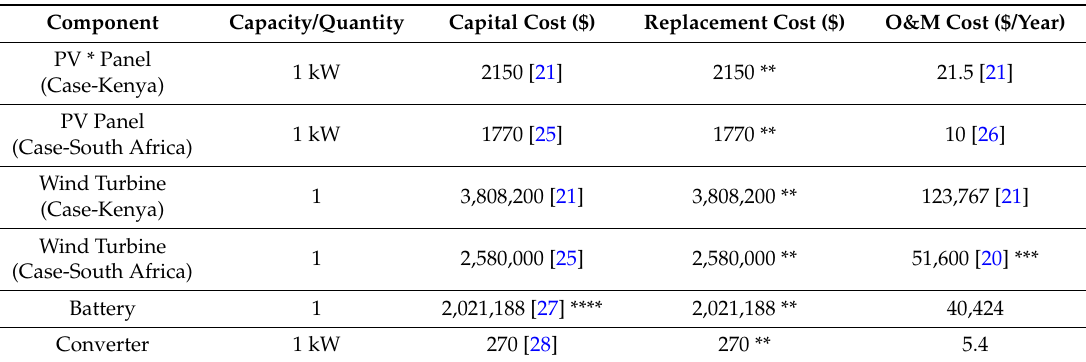
Table 2. Input data of each component used in HOMER